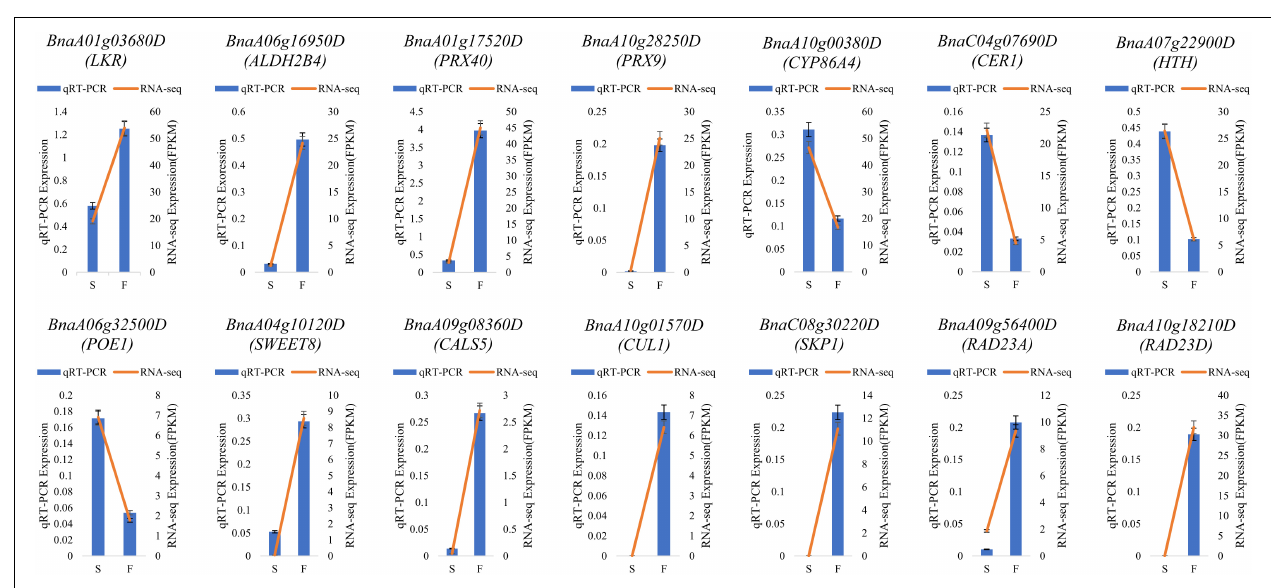
FIGURE 10 | RT-qPCR validation. S, sterile sample; F, fertile